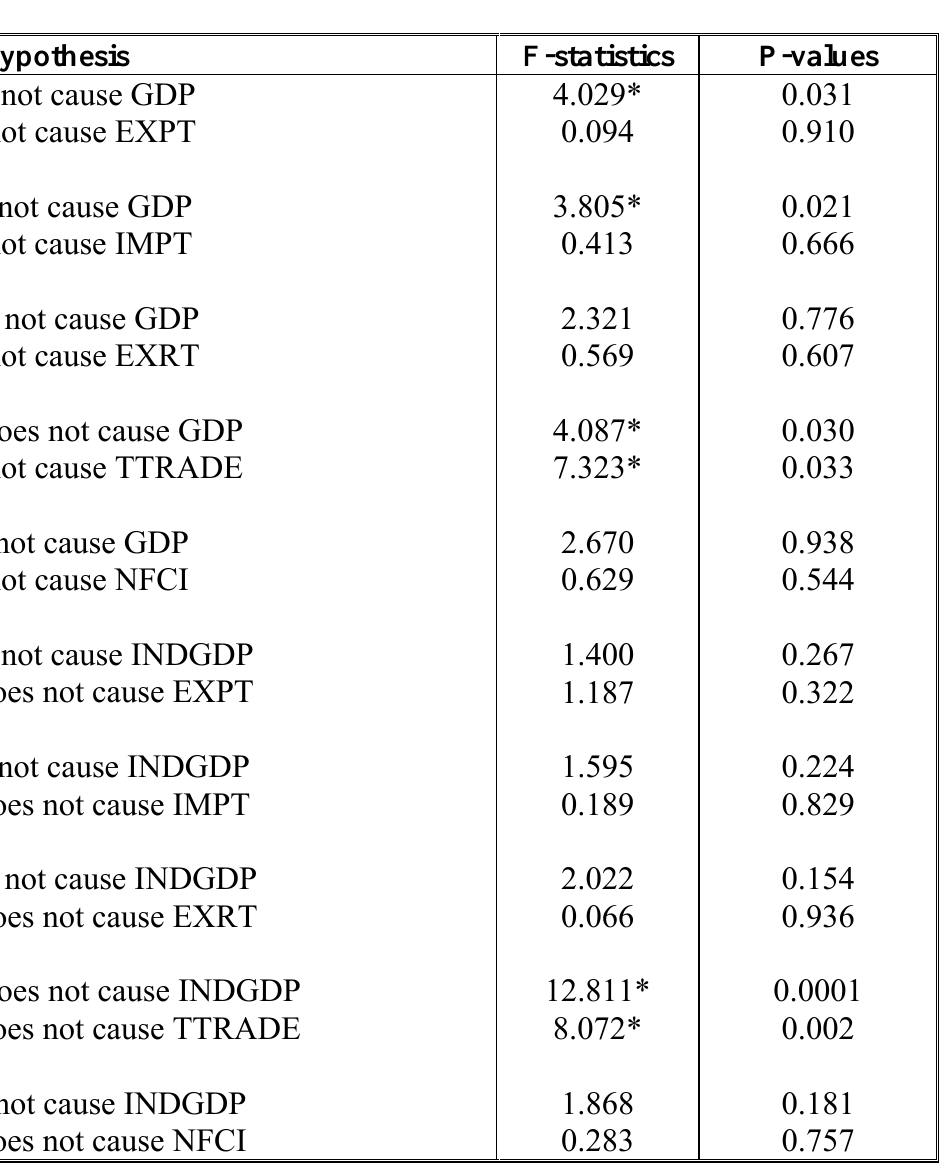
Bivariate Granger causality